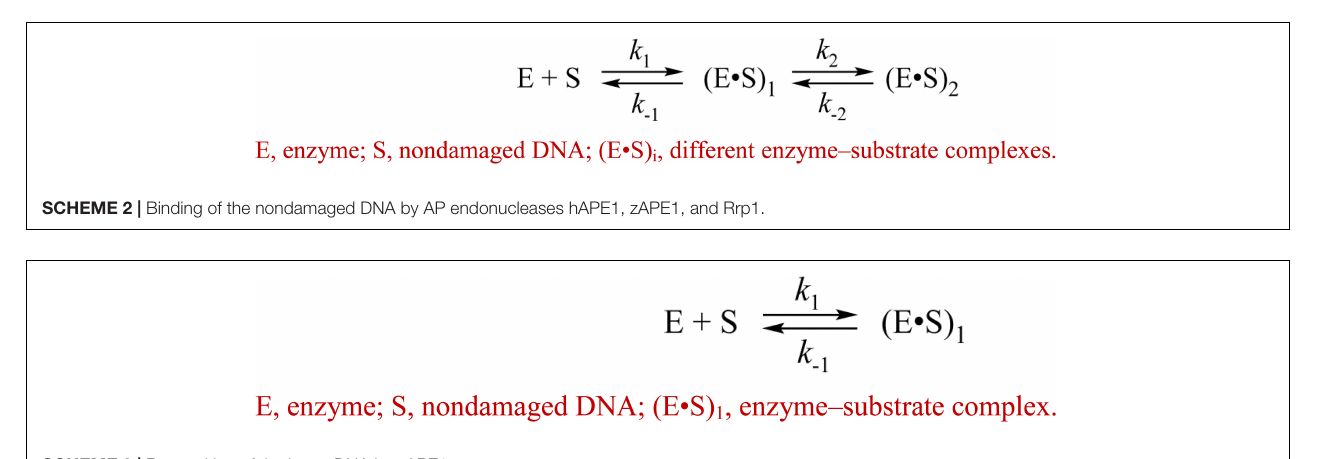
SCHEME 3 | Recognition of the intact DNA by xAPE1.